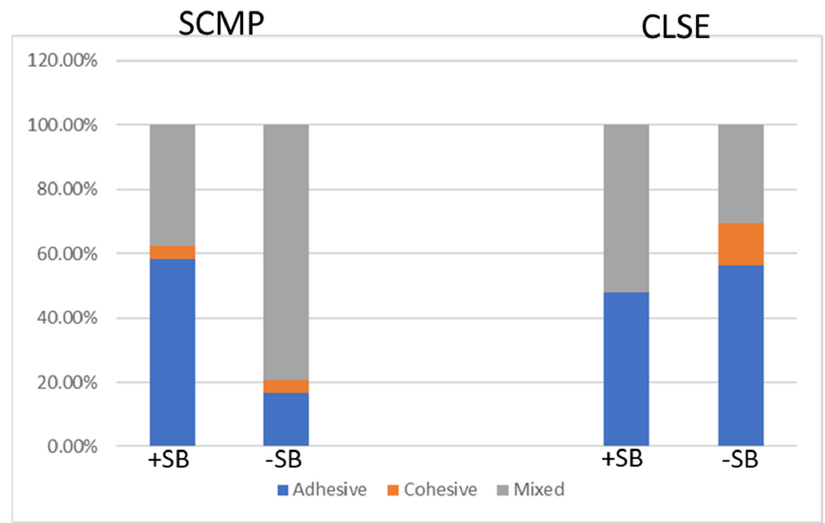
Figure 6. Frequencies of failure modes for the different adhesive systems. SCMP, Scotchbond Multi- Purpose; CLSE, Clearfil SE.